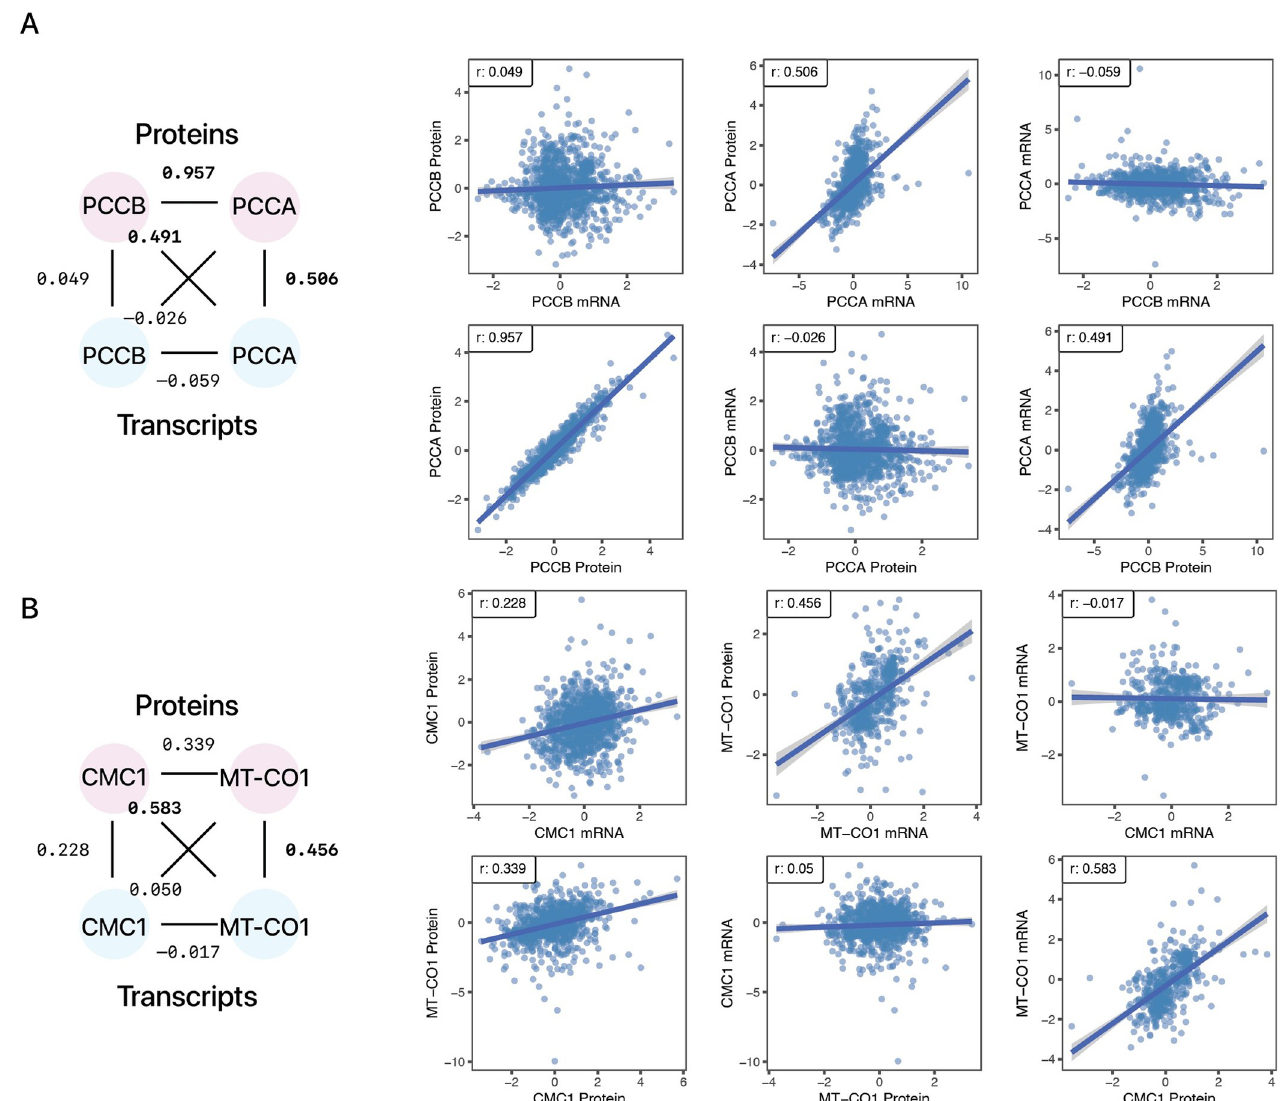
Fig 4. mRNA-Protein correlations of PCCB and CMC1 with functionally associated proteins. Two examples of proteins whose abundance is better explained by another transcript are shown. A. PCCB protein level is predicted by PCCA transcript but not its own transcript. B. CMC1 protein level is explained by MT-CO1 transcript level but not its own transcript. Substantial correlations across transcripts and proteins ( � 0.4) are bolded.